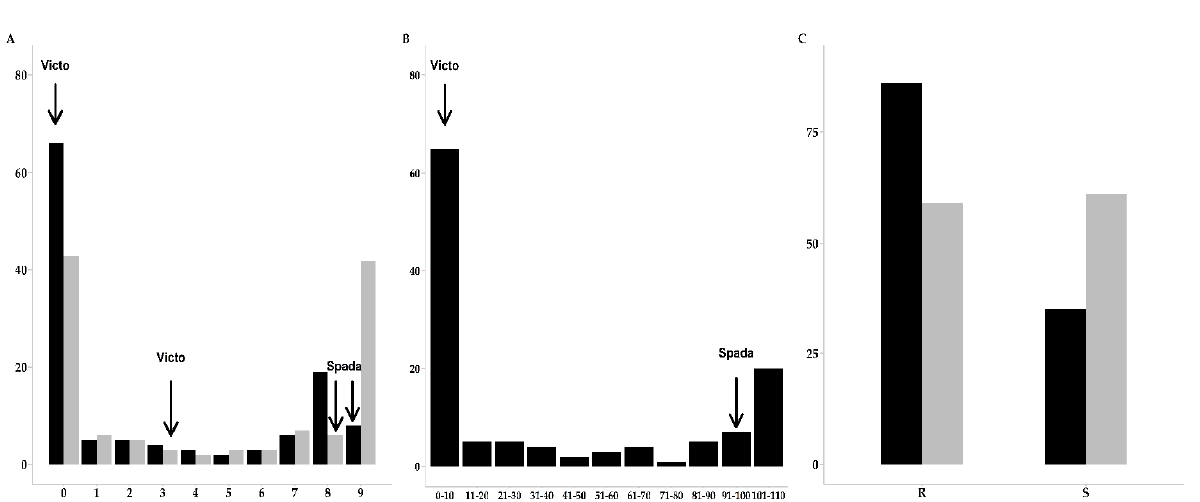
Figure 1. Frequency distribution of phenotypic reaction to leaf rust (black) and powdery mildew (grey) isolates expressed as infection type ( A ) or relative disease severity ( B ). The frequency distribution using the major two classes of infection type were reported ( C ) as resistant (R) and susceptible (S). Reaction scores of the parents are indicated by arrows. The y -axis shows the number of lines.